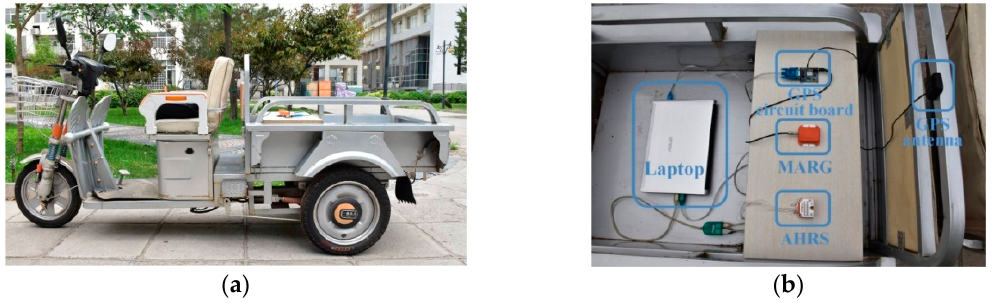
Figure 3. Experimental setup. ( a ) Test vehicle. ( b ) Experimental devices.